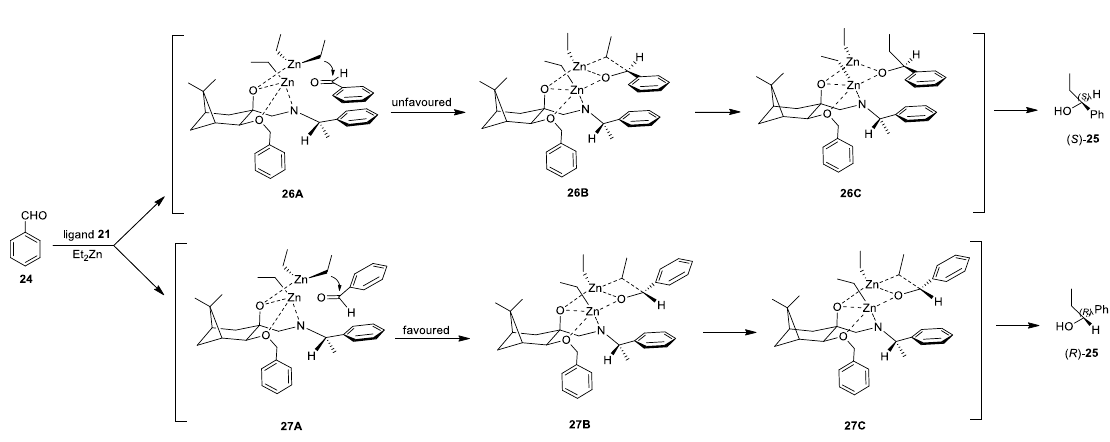
Figure 2. Proposed transition state for the asymmetric addition with 21.